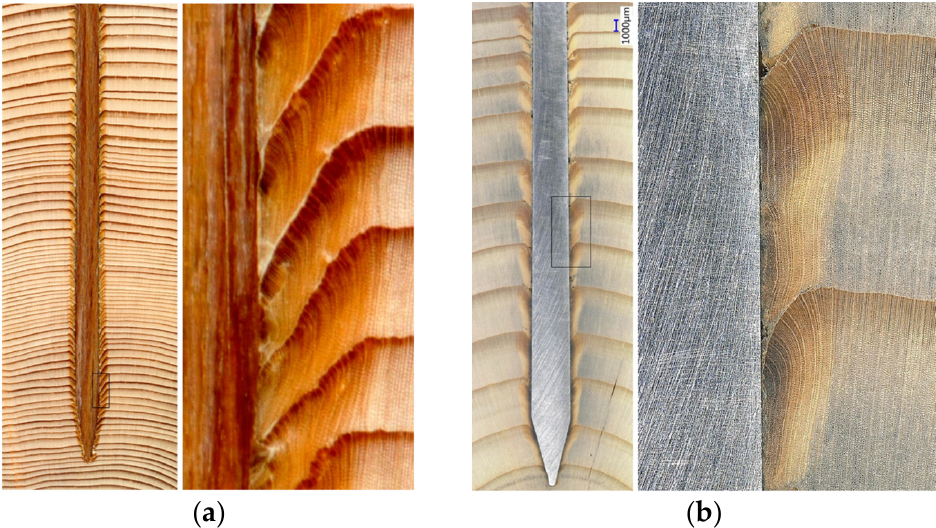
Figure 16. Two types of nails radially inserted into Norway spruce: ( a ) a beech nail, and ( b ) a steel nail, shot with an air nail gun at 6 bar pneumatic pressure. A small darker region of melted and re-solidified lignin can be seen around the nails [123] .